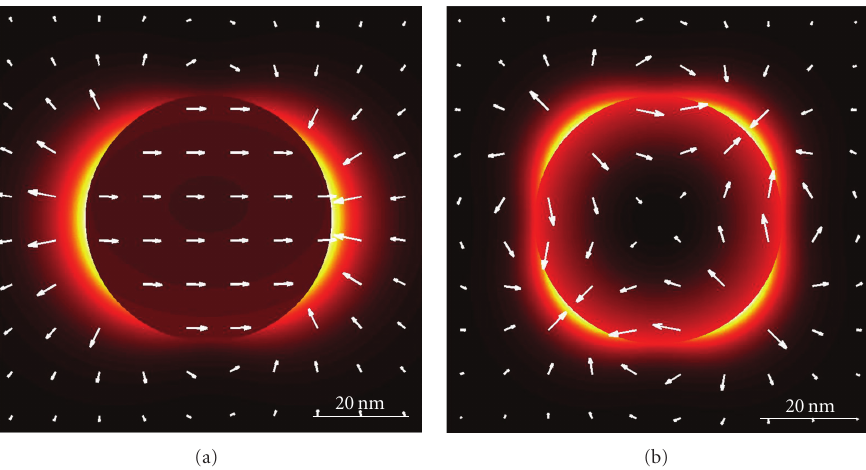
Figure 2: (a) Dipolar and (b) quadrupolar mode profiles of a R = 25nm silver sphere, embedded in PMMA calculated using exact Mie expansion. Silver dielectric constant is taken from [28]. Color and arrows refer to electric field intensity and vector